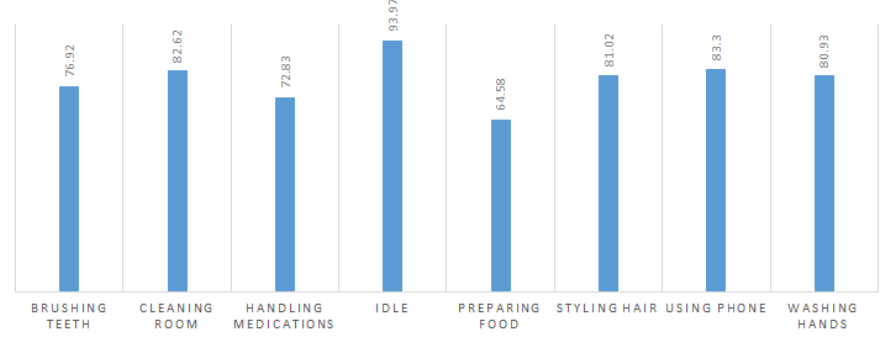
Figure 4. F1 scores for eight composite activities in the online